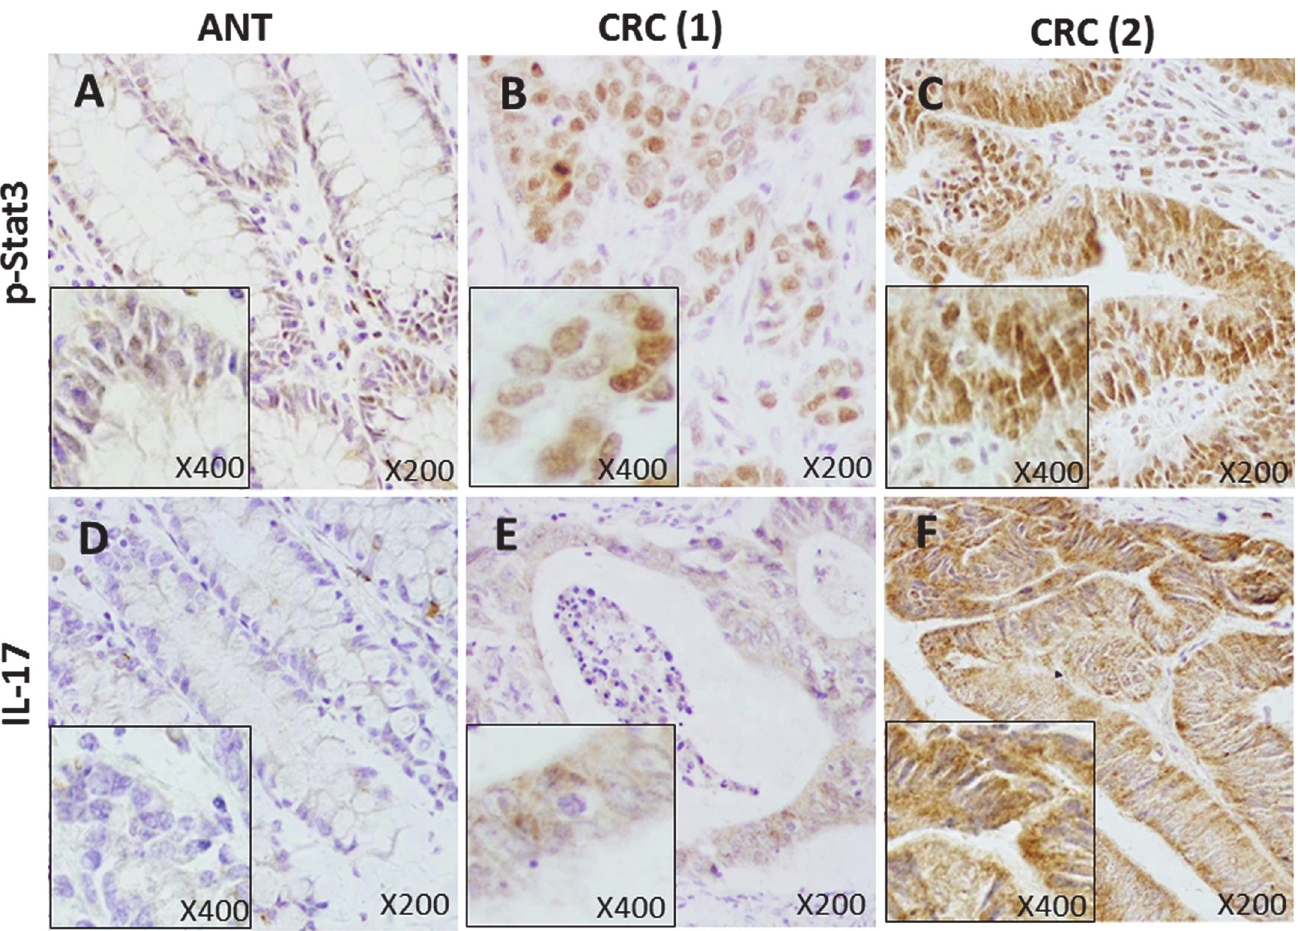
Fig 1. CRC tissues show constitutively over-phosphorylated Stat3 (p-Stat3) and overexpressed IL-17 than adjacent normal tissues (ANT) using IHC method with specific antibodies. Six representative IHC staining panels are shown. Antibody-staining against p-Stat3 is mainly localized in the nucleus (A, B and C, positive staining of yellow-brown), while antibody-staining against IL-17 is primarily in the cytoplasm (D, E and F, positive staining of yellow-brown). A and B came from paired tissues of the same patient but C was from an unrelated tissue. D and E came from paired tissues of the same patient but F was from an unrelated tissue. It can be seen that p-Stat3 is strongly stained in CRC (2) (C, scored as 3+) as compared with another CRC (1) (B, scored as 2+) or ANT tissue (A, scored as negative or 0). Similarly for IL-17, CRC (2) tissue shows strong staining (F, scored as 3+) compared with another CRC (1) (E, scored as 1+) but ANT shows little or no staining (D, scored as negative or 0). Microscopic magnification is X200 with inserts of X400. ANT = adjacent normal tissues and CRC = colorectal cancer,